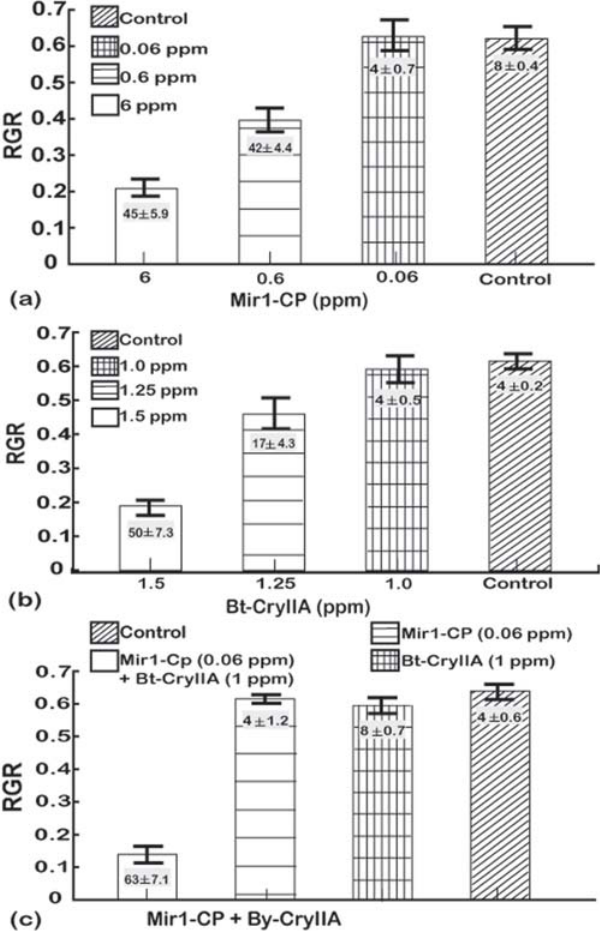
Figure 4. Dose response analysis for southwestern corn borer larvae fed (a) Mir1-CP, (b) Bt-CryIIA, and (c) sub-lethal doses of Bt-CryIIA and Mir1-CP. The y-axis is the relative growth rate (RGR measured as D mg/(mg avg d) and vertical bars indicate one standard deviation. The least significant difference (LSD) at the 0.05 confidence level for the RGR values were as follows: Mir1-CP – 0.15, Bt-CryIIA – 0.23, sub-lethal doses of Bt-CryIIA and Mir1-CP combinded – 0.38. Numbers (mean 6 SD) in the histogram bars are the average percentage mortality for each treatment. The least significant difference (LSD) at the 0.05 confidence level for mortality were as follows: Mir1-CP – 8.97, Bt-CryIIA – 9.24, sub-lethal doses of Bt-CryIIA and Mir1-CP combined – 16.88. Results are based on four independent bioassays. Concentrations are given as parts per million (ppm).